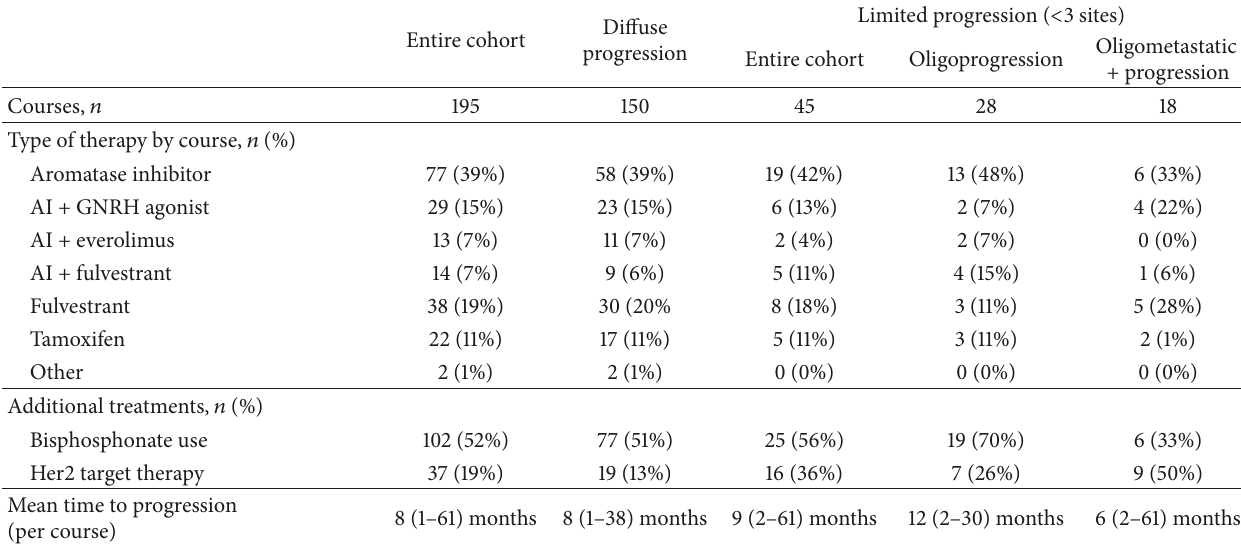
Table 1: Treatment characteristics by course of endocrine therapy.